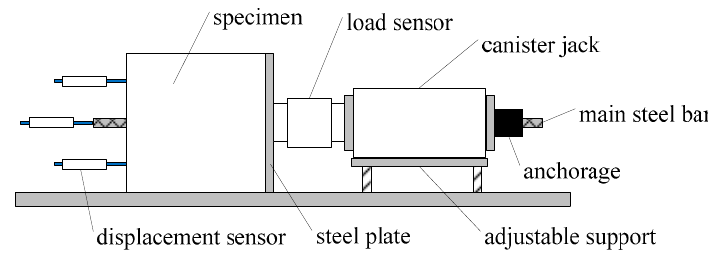
Figure 4. Pull-out test setup.